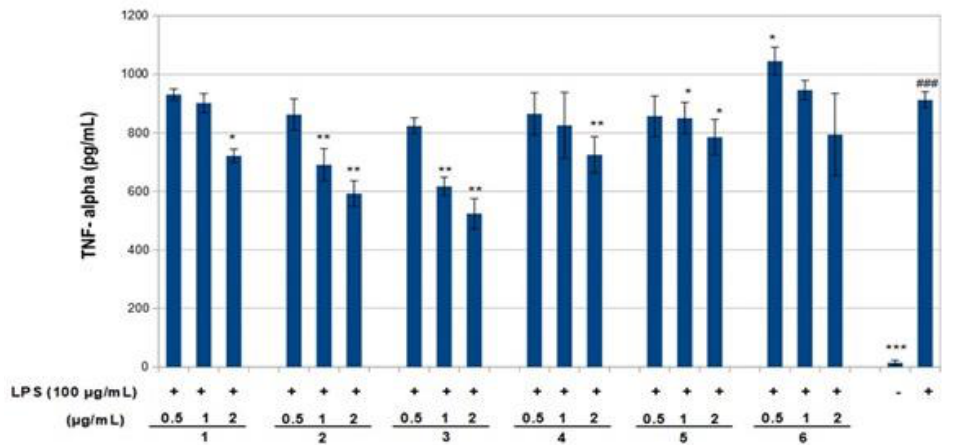
Figure 6. Inhibition of tumor necrosis factor-α (TNF-α) production by compounds 1 – 6 in LPS-stimulated RAW 264.7 macrophages. RAW 264.7 cells were stimulated by LPS (100 ng/mL) for 6 h then treated with various concentrations of compounds 1 – 6 for 24 h. TNF-α production was measured using the corresponding ELISA kits. Values are presented as mean ± standard deviation of three independent experiments. ### p < 0.001 control group as compared to LPS-treated group. * p < 0.05, ** p < 0.01, and *** p < 0.001 were compared with the LPS-alone group. -: cells without treatment, +: cells previously treated with LPS.